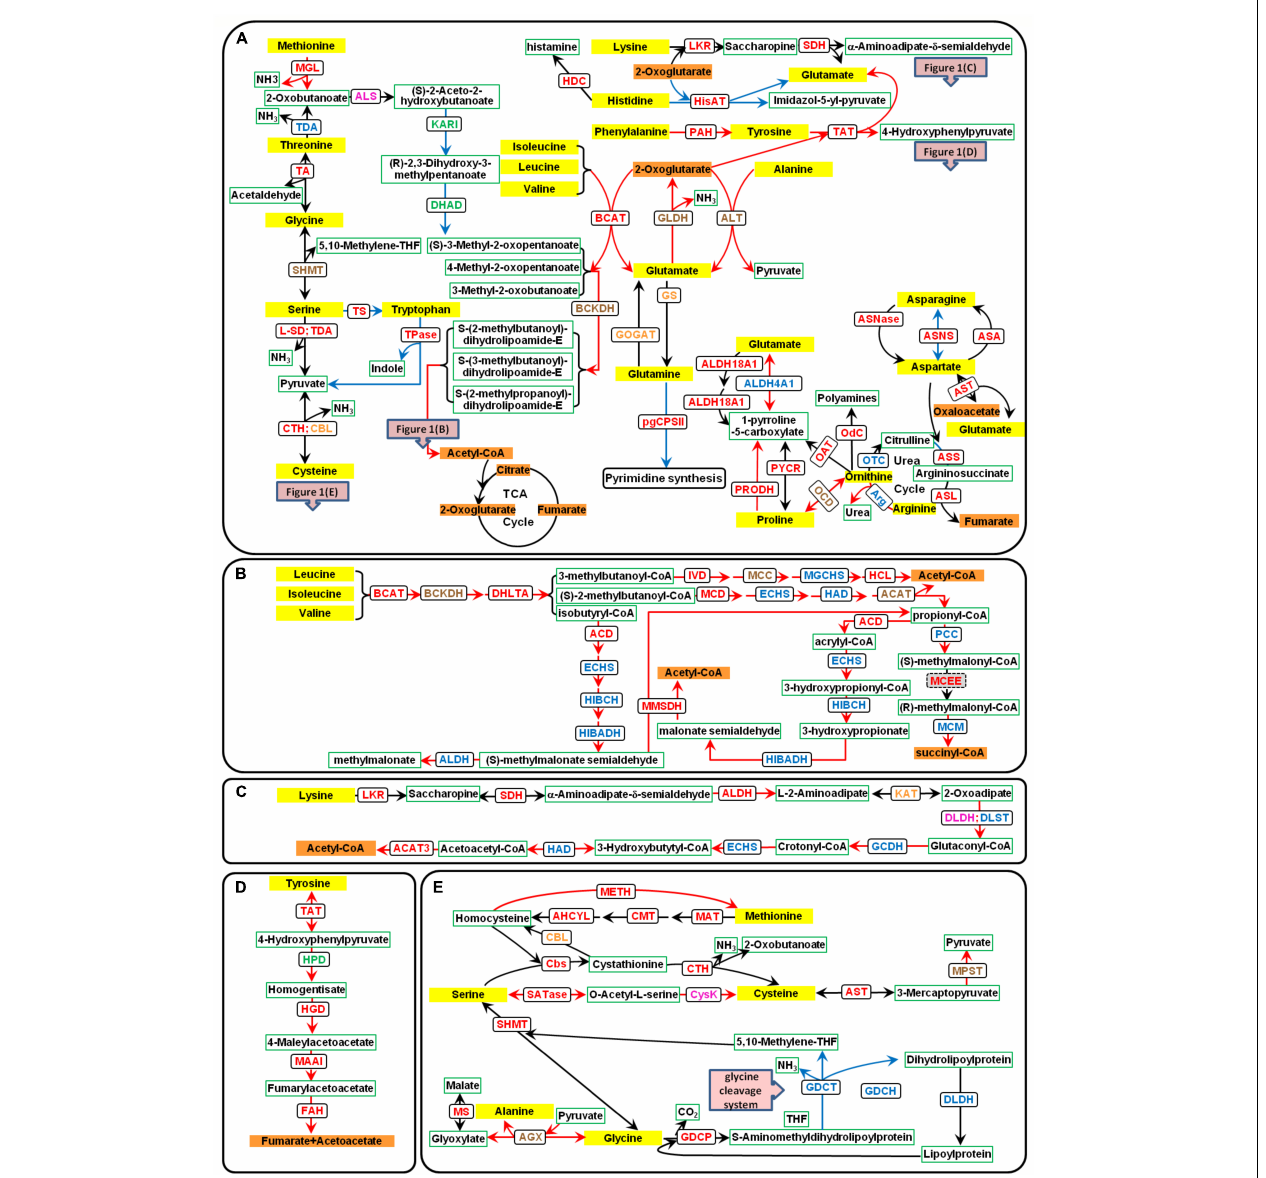
FIGURE 1 | Amino acid catabolic pathways in P. tricornutum . The yellow text box represents amino acids, the orange text boxes indicate metabolites that could enter the TCA cycle, the white text boxes with green borders indicate other metabolites, and the white text boxes with black borders indicate the enzymes. The different font colors of enzymes represent different predicted subcellular locations: plastid localization in green font; mitochondria location in blue font; multiple isoenzymes with the plastid and mitochondria localization in orange font; those with mitochondria and other location in brown font; those with plastid and other localization in purple font; and those with plastid, mitochondria, and other localization in red font. Up-regulated genes are indicated with red lines, and down-regulated genes with blue lines. (A) Catabolic pathways of all 20 amino acids. (B) Catabolic pathways of BCAAs. (C) Catabolic pathways of lysine. (D) Catabolic pathways of tyrosine. (E) Catabolic pathways of serine, methionine, cysteine, and glycine. ACAT, acetyl-CoA C -acyltransferase (EC2.3.1.16); ACD, acyl-CoA dehydrogenase (EC1.3.8.1); AGX, alanine–glyoxylate aminotransferase (EC:2.6.1.44); AHCYL, adenosylhomocysteinase (EC3.3.1.1); ALDH, aldehyde dehydrogenase (EC1.2.1.31); ALDH18A1, delta-1-pyrroline-5-carboxylate synthetase (EC2.7.2.11 and EC1.2.1.41); ALDH4A1, 1-pyrroline-5-carboxylate dehydrogenase (EC1.2.1.88); ALS, acetolactate synthase (EC2.2.1.6); ALT, alanine transaminase (EC2.6.1.2); Arg, arginase (EC3.5.3.1); ASA, aspartate–ammonia ligase (EC6.3.1.1); ASL, argininosuccinate lyase (EC4.3.2.1); ASNase, asparaginase (EC3.5.1.1); ASNS, asparagine synthase (EC6.3.5.4); ASS, argininosuccinate synthase (EC6.3.4.5); AST, aspartate aminotransferase (EC2.6.1.1); BCAT, branched-chain amino acid transaminase (EC2.6.1.42); BCKDH, branched-chain α -keto acid dehydrogenase (EC1.2.4.4); CBL, cysteine- S -conjugate beta-lyase (EC4.4.1.13); Cbs, cystathionine beta-synthase (EC4.2.1.22); CMT, DNA (cytosine-5)-methyltransferase (EC2.1.1.37); CPSII, carbamoyl-phosphate synthase II (EC6.3.5.5); CTH, cystathionine gamma-lyase (EC4.4.1.1); CysK, cysteine synthase (EC2.5.1.47); DHAD, dihydroxy-acid dehydratase (EC4.2.1.9); DHLTA, dihydrolipoyllysine-residue (2-methylpropanoyl) transferase (EC2.3.1.168); DLDH, dihydrolipoyl dehydrogenase (EC1.8.1.4); DLST, dihydrolipoamide succinyltransferase; ECHS, enoyl-CoA hydratase (EC4.2.1.17); FAH,